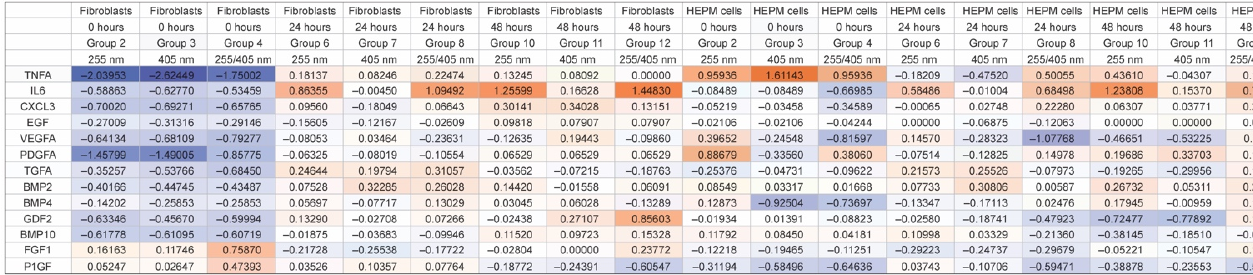
Figure 2. Expression Log2 ratios of 13 chemokine, cytokine, and biomarker (CCBMs) concentrations reported in tissue culture media of HEPM cells and gingival fibroblasts at 0, 24, and 48 h after treatment with 255 nm, 405 nm, or 255/405 nm UV irradiation. Expression was calculated as the log2 ratio of the mean of each treatment after UV irradiation over the mean of the untreated control for that same cell type, UV irradiation wavelength, and time period. Groups are shown as a heatmap, where blue represents inhibition (negative values), white represents midpoint, and orange represents activation (positive